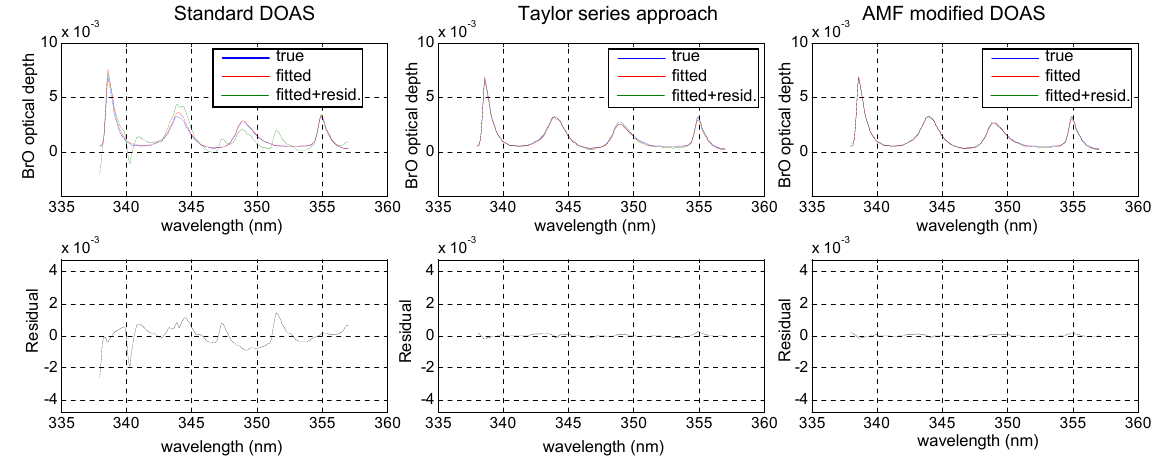
Fig. 5. Left panel: Retrieved optical depth of BrO for TH=22.8km by the standard DOAS fit. Middle panel: same but for the Taylor series approach. Right panel: same but for AMF modified DOAS for ozone. Top panels show the true optical depth of BrO (blue), fitted optical depth of BrO (red) and the optical depth plus residual structures (green). The bottom panels show the residuals alone. rapidly with wavelength. An alternative retrieval is per- formed with box AMFs calculated at a single wavelength of 344.2 nm. At this wavelength, the retrieved BrO SCDs agree with the true SCDs of BrO within ∼ 3% for different ozone profiles as it is deduced from sensitivity studies, see e.g. Fig. C1, second panel from top, in the Appendix C. The obtained vertical concentration profiles are shown to- gether with the true profile in Fig. 4 (middle panel), the dif- ference is plotted in the right panel. The profile retrieved from SCDs acquired by standard DOAS shows a shift up- wards (by ∼ 1.5 km) and too large values at the peak by ∼ 10%. The overestimation above the peak is more than 20 or 25% for altitudes with large ozone concentration, i.e. around 20 km (compare with Fig. 2). On the other hand, the profile obtained by AMF modified DOAS or the Taylor series ap- proach agrees much better with the true profile. For altitudes between 15 and 28 km the agreement for the Taylor series approach is better than 5%. For altitudes below 15 km the discrepancy increases to ∼ 10% (note that below 12 km the measurement response is very